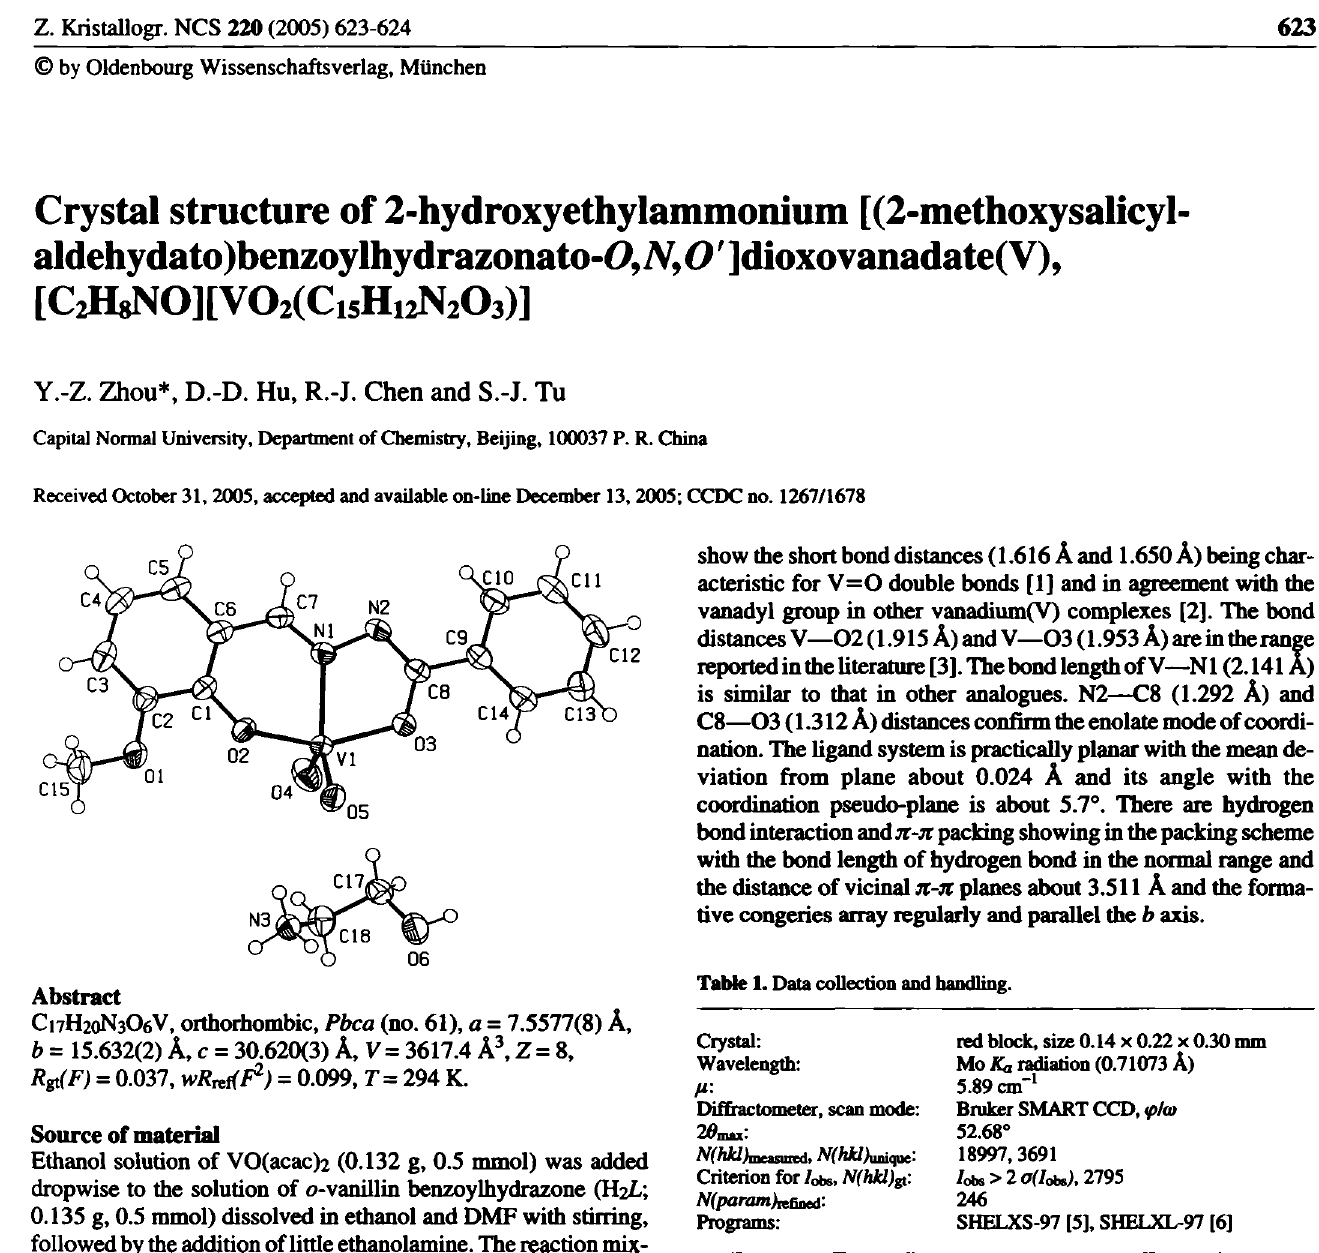
Table 2. Atomic coordinates and displacement parameters (in Ä 2